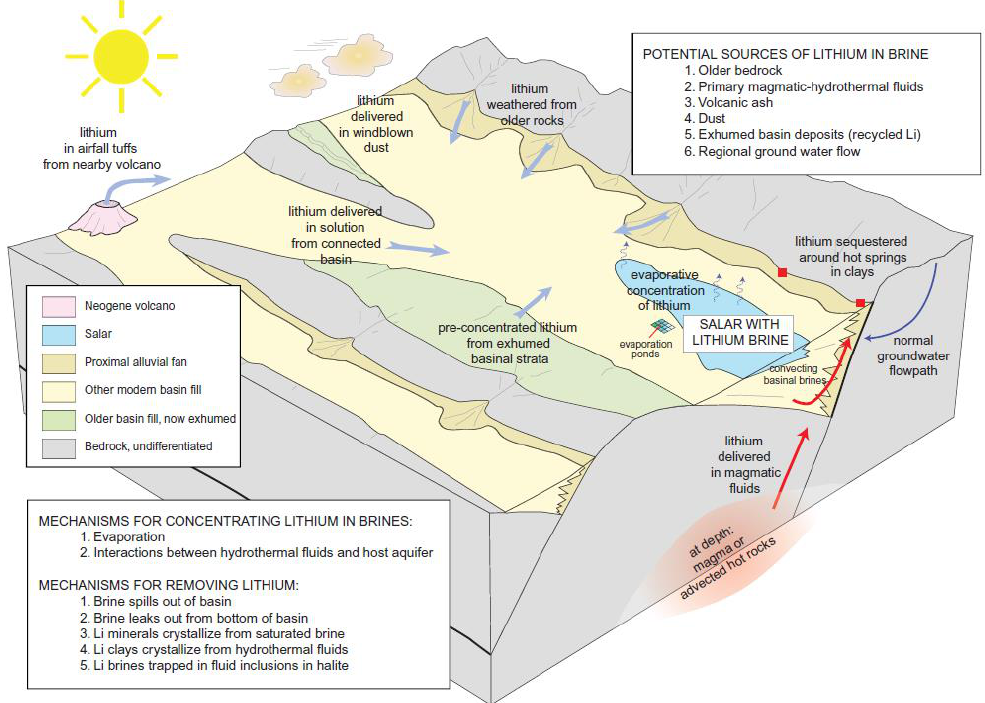
Figure 1. Summary diagram of the geological, geochemical and hydrological features of lithium brine [9]. Lithium can be found concentrated in areas subject to volcanic influences. Reproduced with permission of the Society of Economic Geologists, Inc. Munk et al. (2016) Chapter 14: Lithium brines: A global perspective, Reviews in Economic Geology, v. 18, 339 – 365.